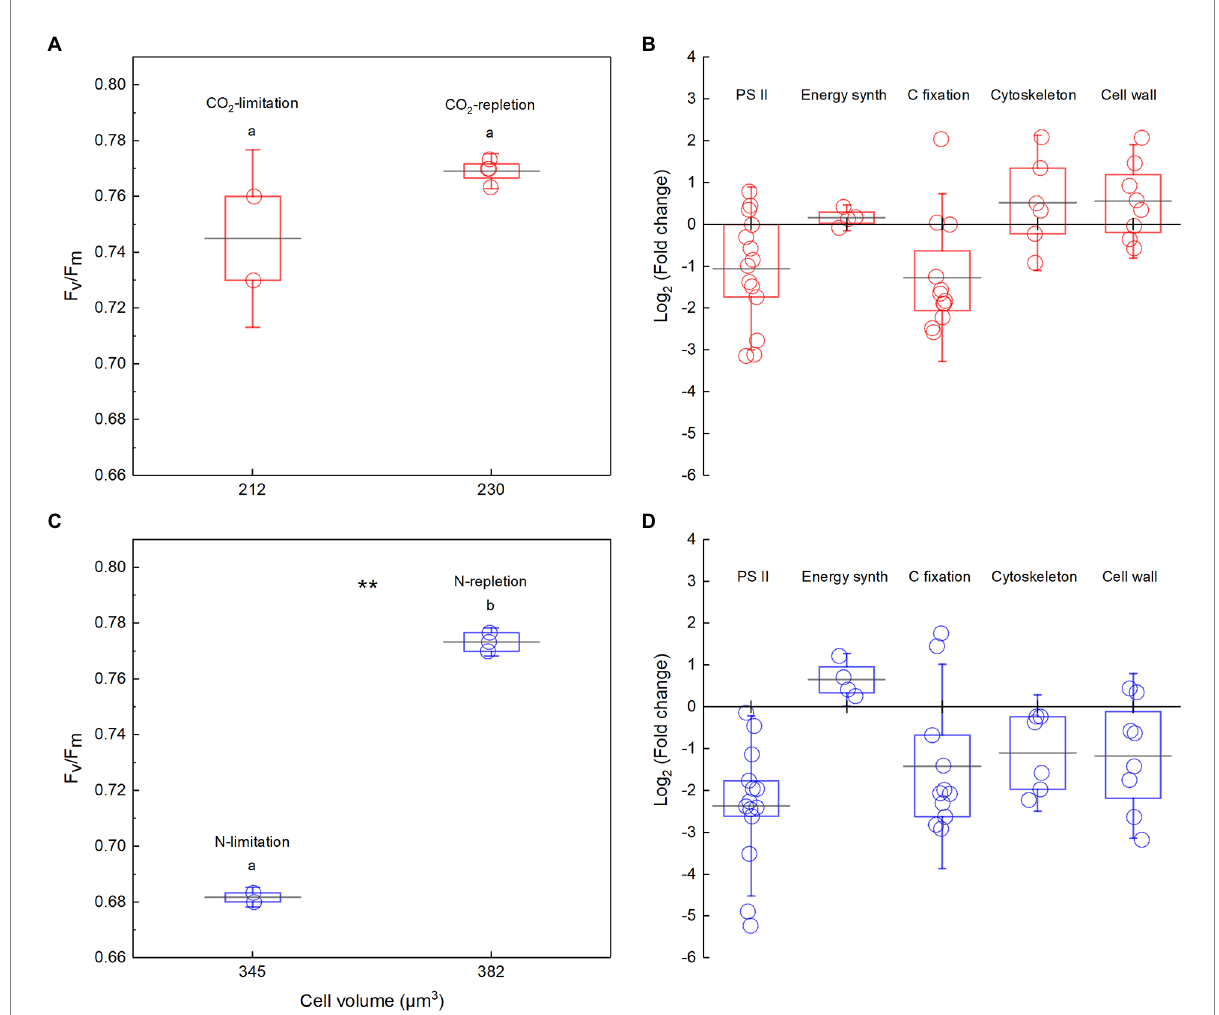
FIGURE 4 (A) F v / F m and cell volume of Chlamydomonas reinhardtii under different CO 2 concentration conditions. (B) The fold change of gene expression of proteins involved in Photosystem II (PS II), energy synthesis (energy synth), carbon fixation (C fixation), cytoskeleton, and cell wall under CO